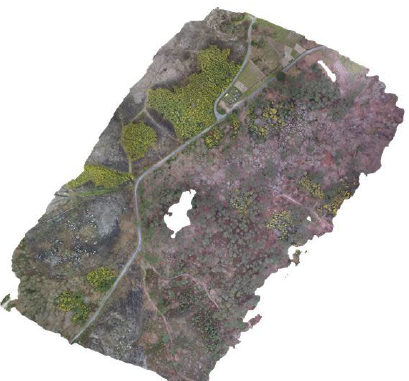
Figure 4 Resulting orthomosaic of the photogrammetric survey based on UAV